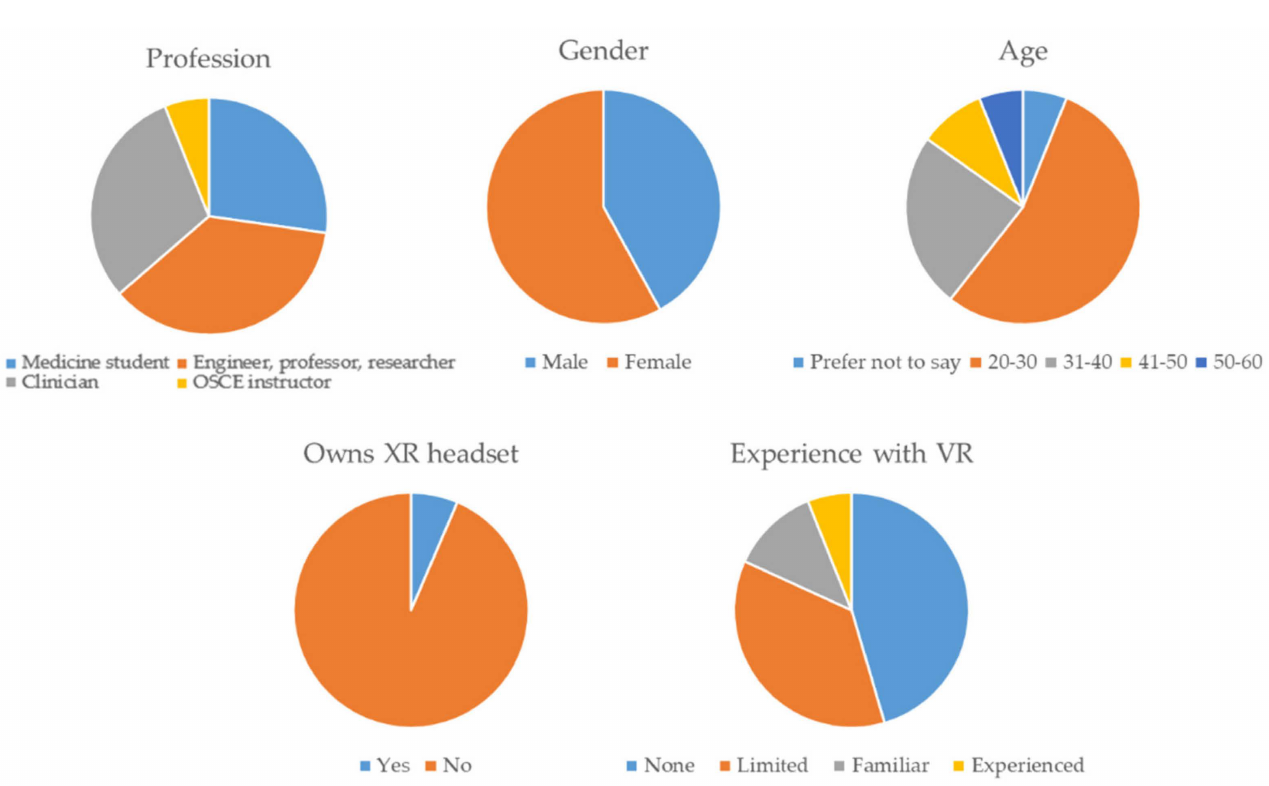
Figure 8. Summary of personal information and familiarity with VR and XR from participants in the validation protocol. Regarding experience: None refers to people that never used VR technology, Limited to people using technology less than once a month, Familiar to people using technology about once a month and experience to people using technology several times a